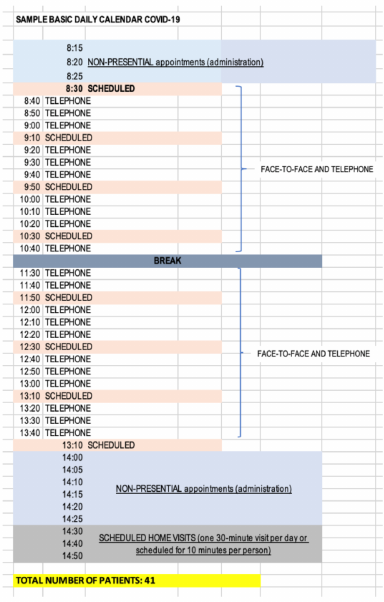
Figure 10. Covid-19 period